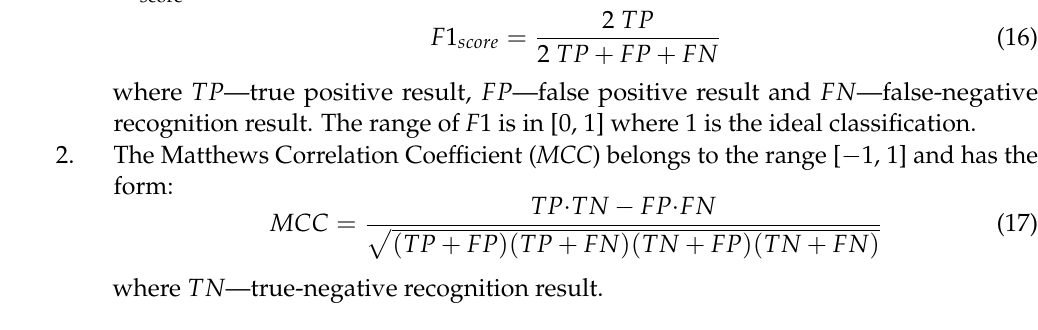
Table 3. Comparison of the recognition accuracy of a noisy and cleaned by different methods image database CIFAR 10.